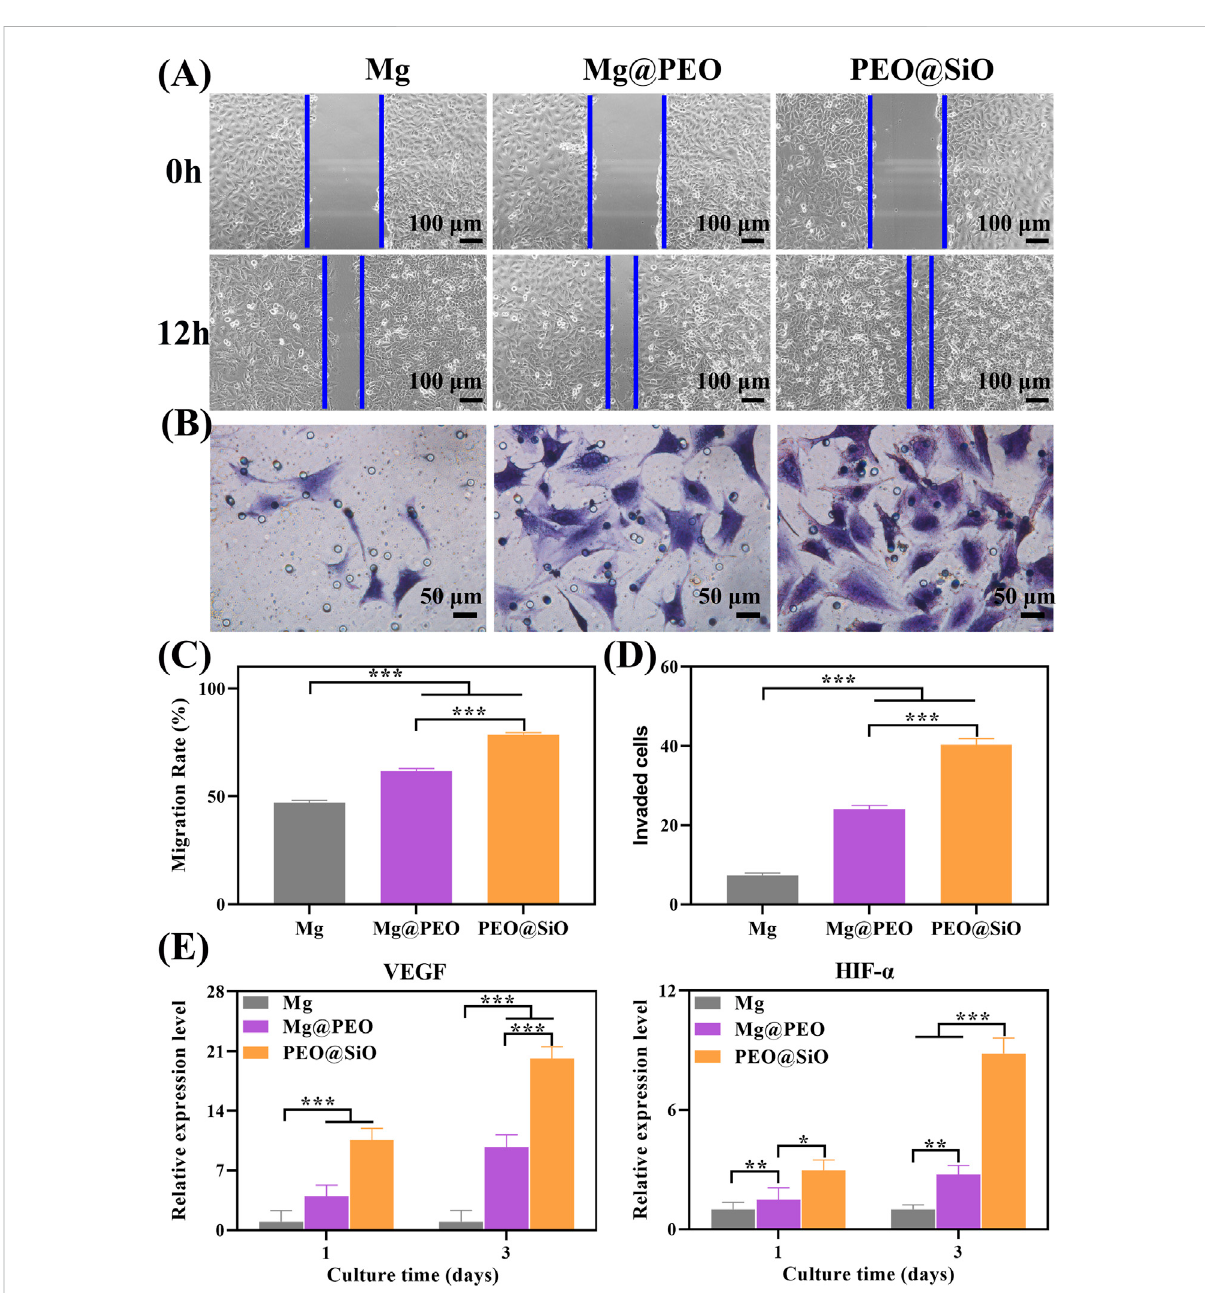
FIGURE 6 In vitro angiogenic ability: (A) Migration of HUVECs cultured for 12 h were evaluated by wound healing assay, and corresponding quantitative results are shown in (C) ; (B) Crystal violet staining of migrated HUVECs cultured for 24 h in a transwell assay, with corresponding number of invaded cells is shown in (D) ; (E) Relative mRNA expressionof angiogenesis-related genes including VEGF and HIF- α for HUVEC cultured on various samples for 1 and 3 days; * p < 0.05, ** p < 0.01, and *** p <